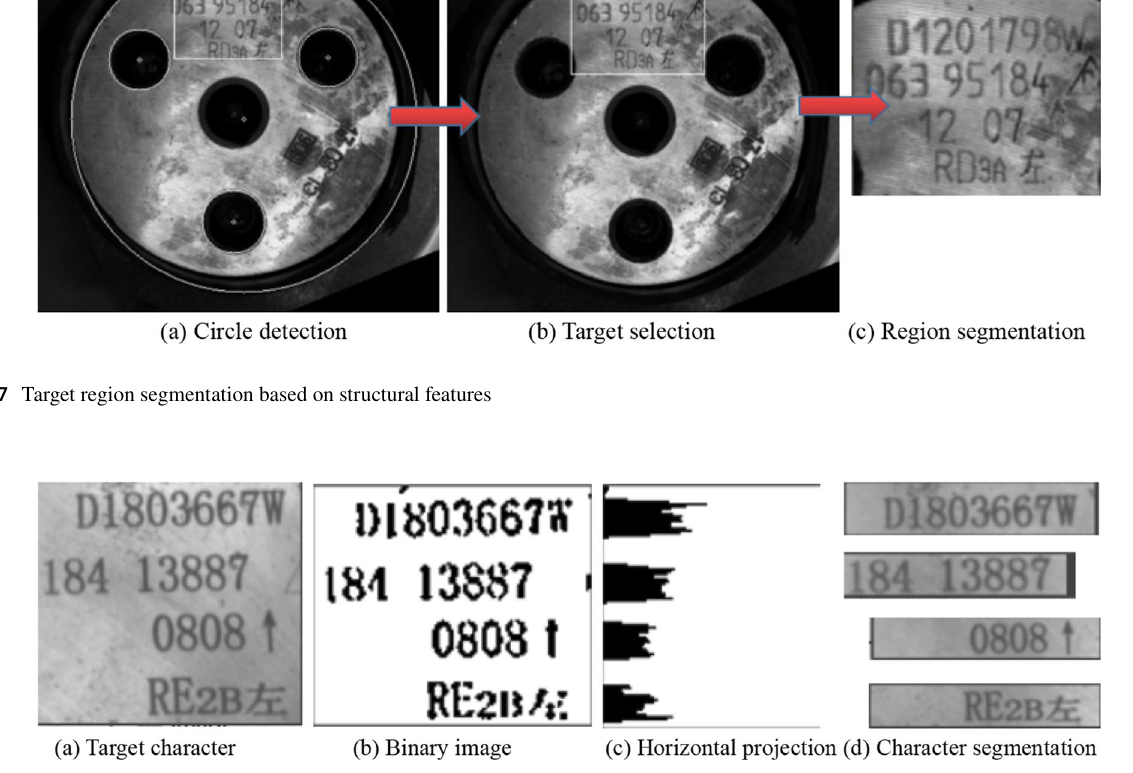
Fig. 18 Line segmentation